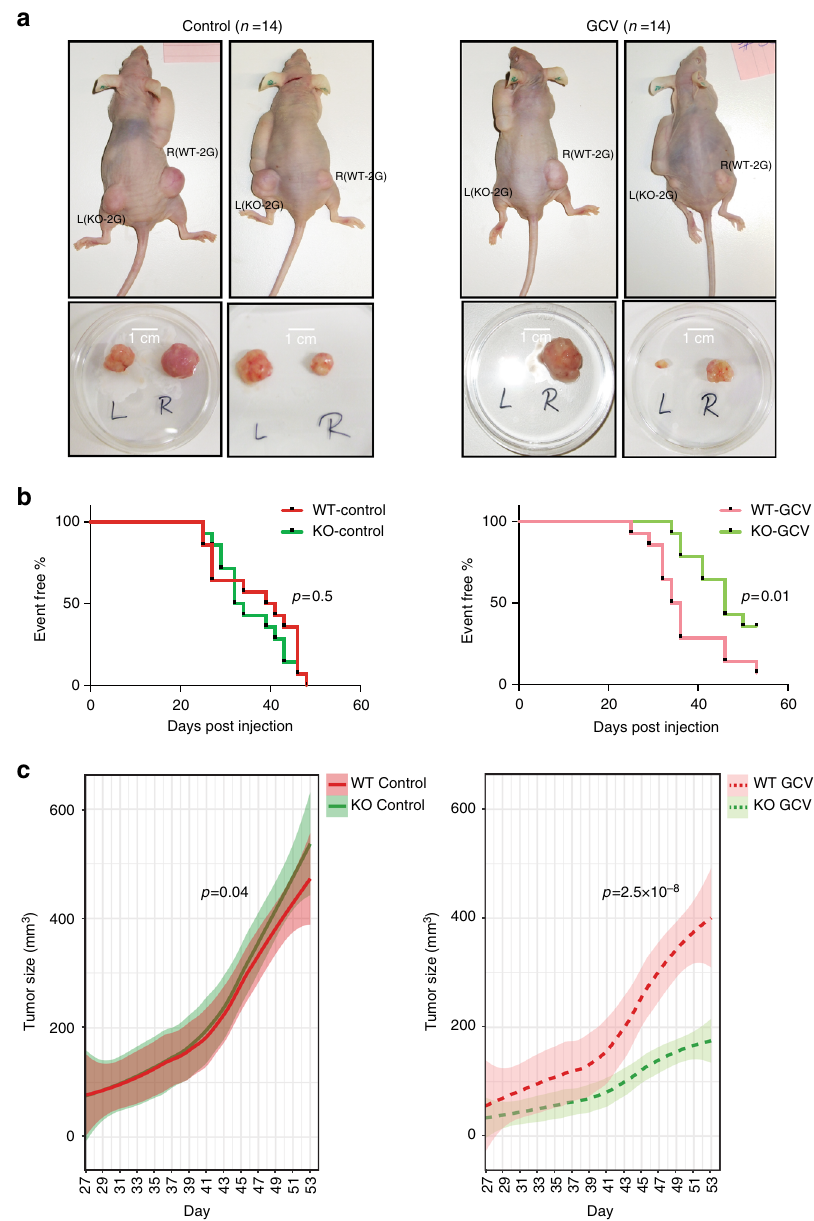
Fig. 5 GCV speci fi cally targets KO-2G tumors in vivo. a Top; representative in vivo images of WT-2G (right fl ank) and KO-2G (left fl ank) tumors 77 and 56 days post injection in control treatment group (water; left), and 86 and 82 days post injection in GCV-treated (right) mice. Bottom; ex vivo images of WT-2G and KO-2G tumors taken from the corresponding mice. b Kaplan – Meier graphs showing the proportion of mice without palpable tumors (set volume of 100 mm 3 ) as a function of post-injection time (in days) for mice in control (left) and GCV-tretaed (right) groups. p -values comparing time to palpability between WT-2G and KO-2G tumors are shown. c Average tumor volume of WT-2G and KO-2G tumors is given as a function of post-injection time (in days) for control group of mice ( n = 14, the left panel), and GCV treatment group ( n = 14, the right panel). The curves show results of loess regressions of tumor sizes over time (span = 0.75) and the semi-transparent ribbons indicate 0.95 con fi dence intervals around the smooth. Indicated p - values are results of likelihood ratio tests comparing linear mixed effects models to respective nested models without an effect of cell type on tumor